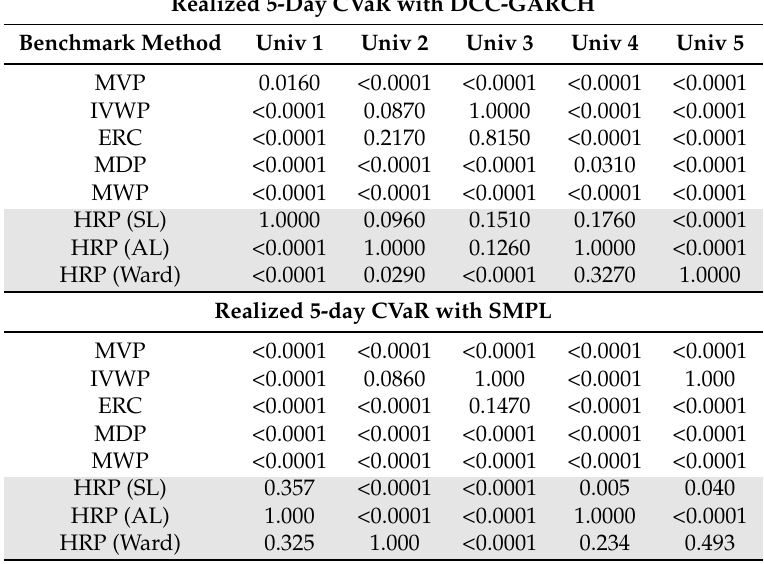
Table 6. p c -values for different portfolio allocation benchmark models considered when weekly expected shortfall is taken as the loss function and the portfolio is rebalanced daily. The highlighted cells are outcomes for variants of